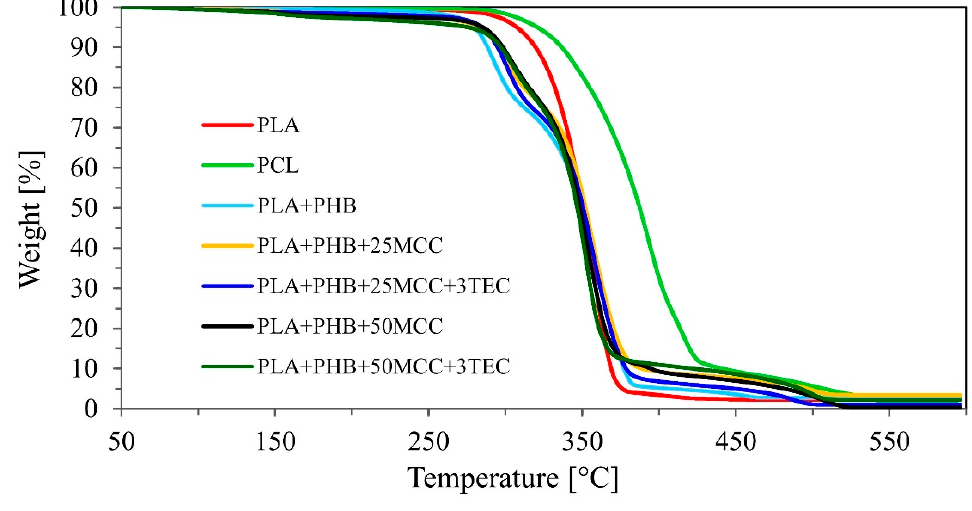
Figure 2. Thermogravimetric analysis (TGA).